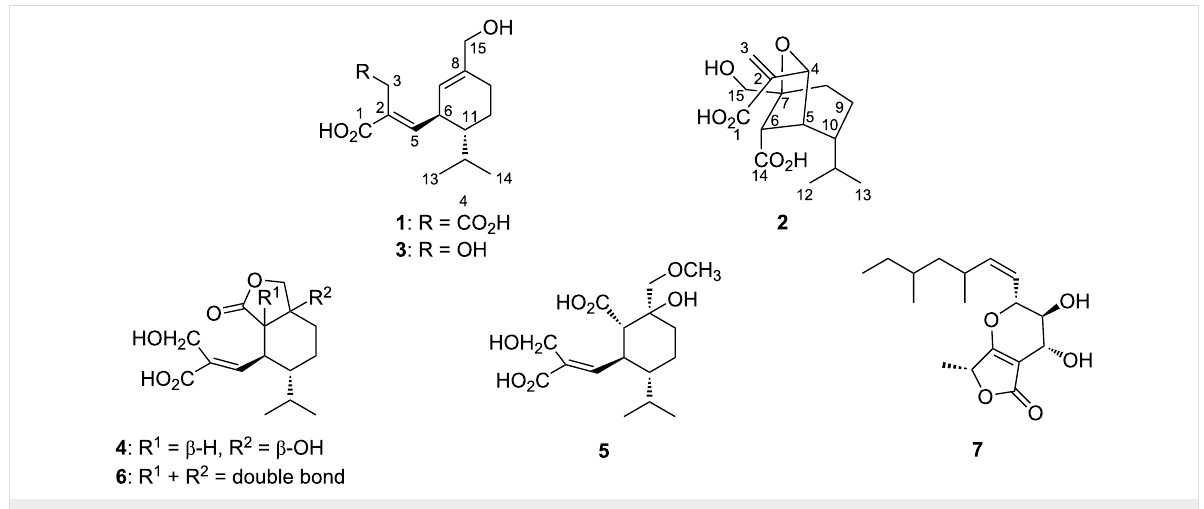
Figure 1: Structures of compounds 1 – 7 isolated from Trichoderma citrinoviride PSU-SPSF346.